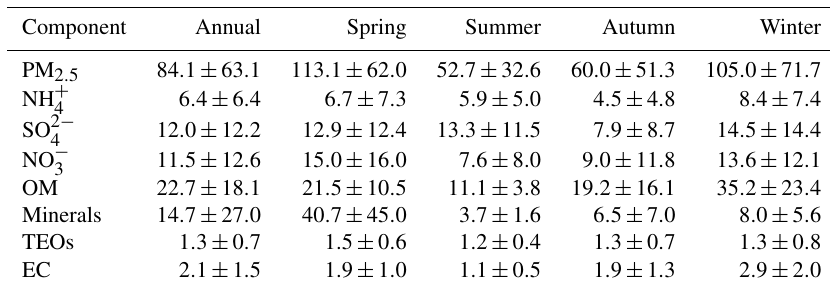
Table 1. Annual and seasonal mean concentrations (µgm − 3 , ± 1 standard deviation) of PM 2 . 5 and its seven major known components.